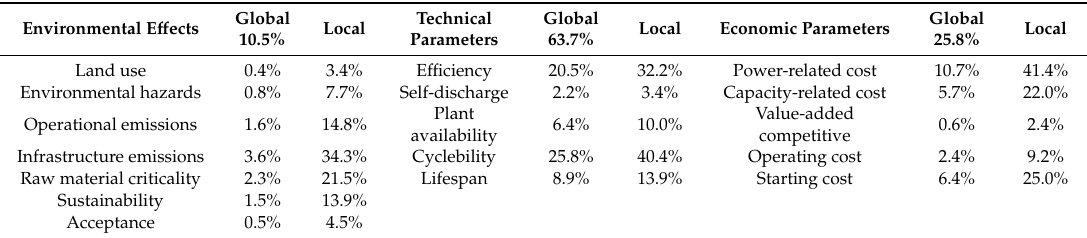
Table 2. Global and local weighing factors for short-term electrical energy storage